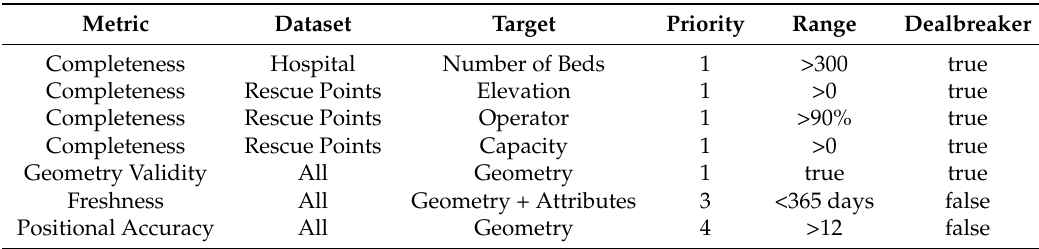
Table 9. Joint Requirement Profile: For the usecase of a rescue operation to hospitals, the mission can only be planned if the hospitals capacity is known, the rescue points are operative, geometries are valid and accurate, and the map is up to